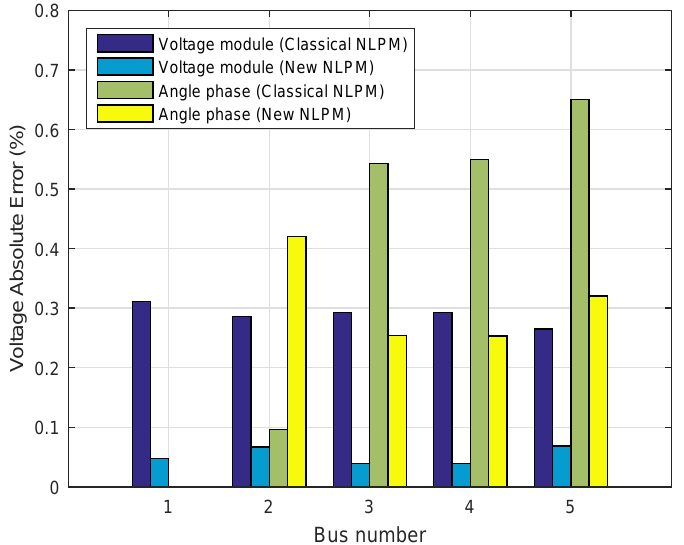
Figure 3. Voltage absolute error of the 5-bus power system.